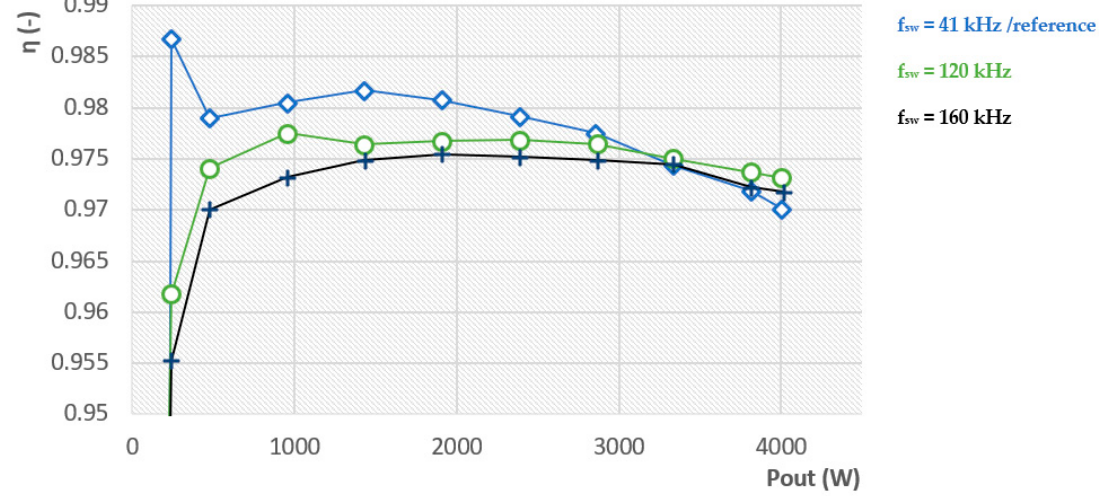
Figure 8. Efficiency characteristic of analyzed non-optimized PFC converter in dependency on the output power and switching frequency (equipped with IMW120R060M1H SiC transistor).